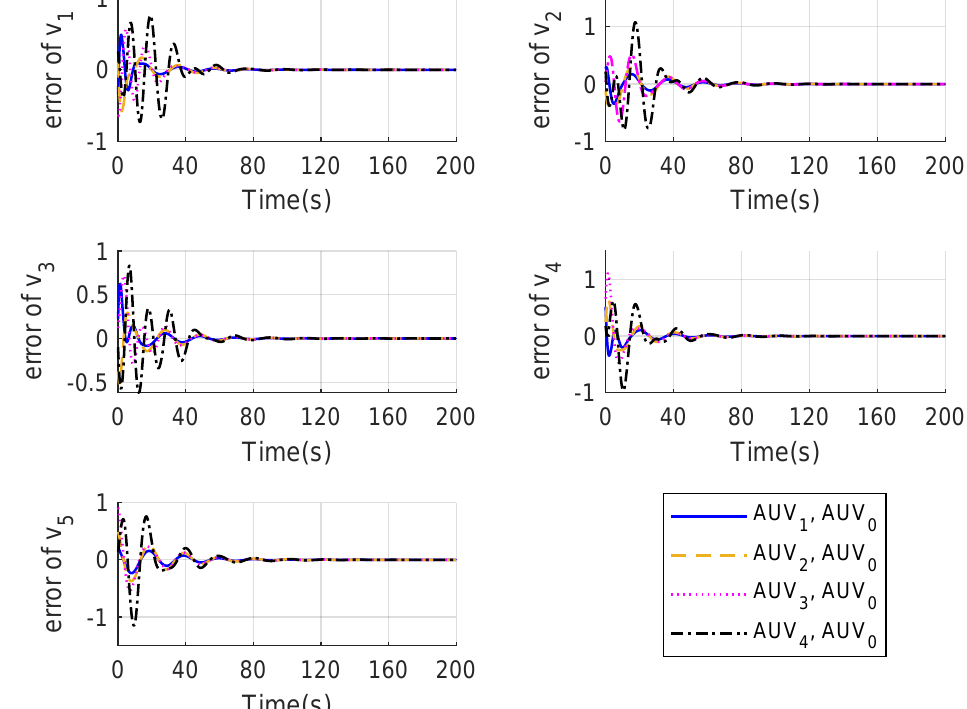
Figure 15. Errors of velocity state under alterable communication topology with